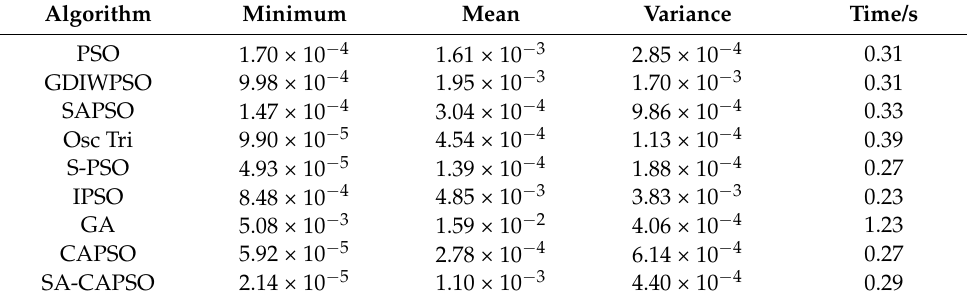
Table 10. Test results of test function F3.